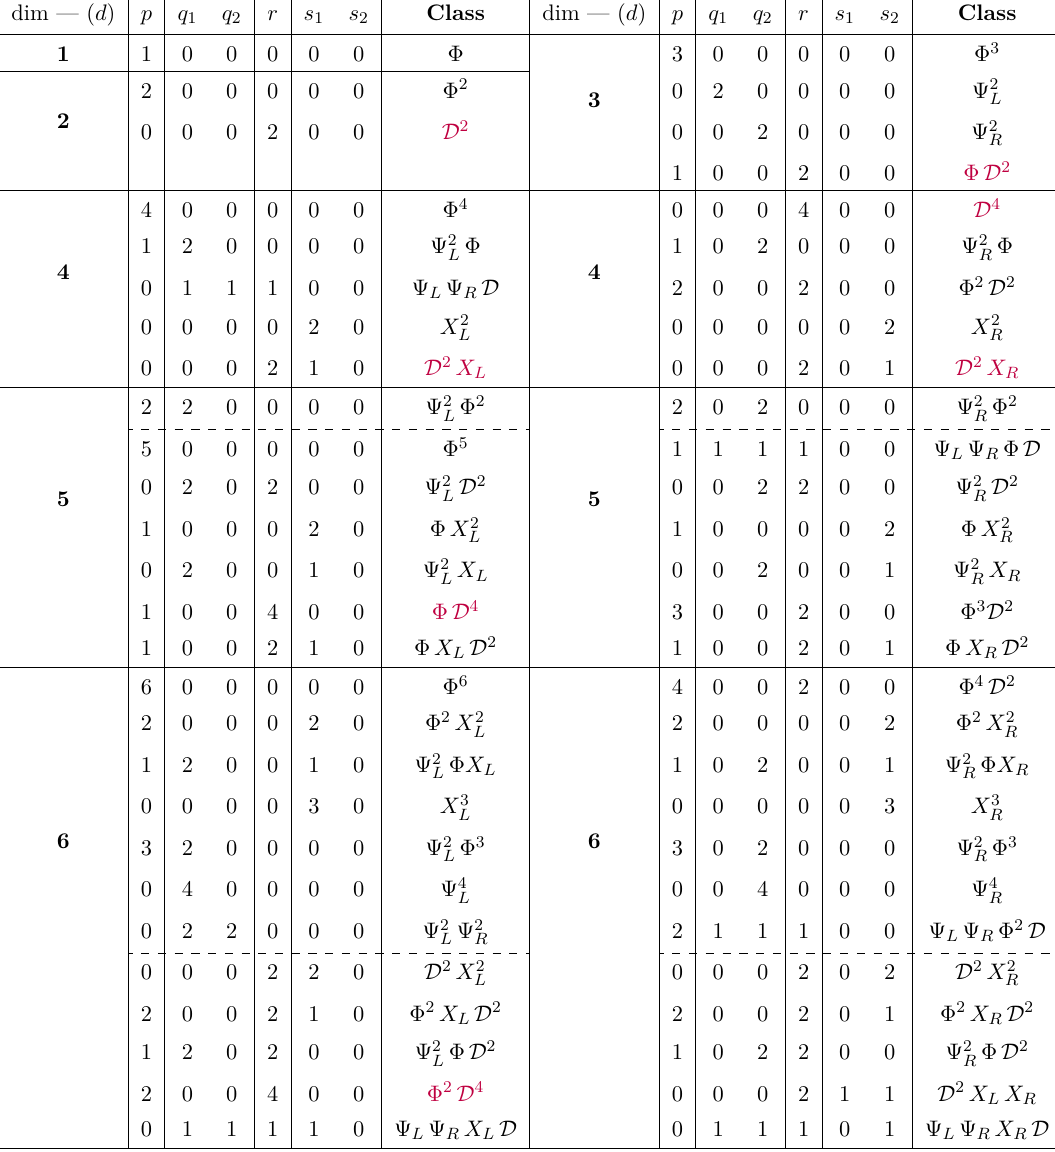
Table 1 . Lorentz Invariant Operator classes (in Weyl representation) upto mass dimension 6. For the case of dimensions 5 and 6, only the operator classes above the dashed line appear in SMEFT. The terms in red are total derivative terms and are therefore excluded from the Lagrangian. These operator classes are not all